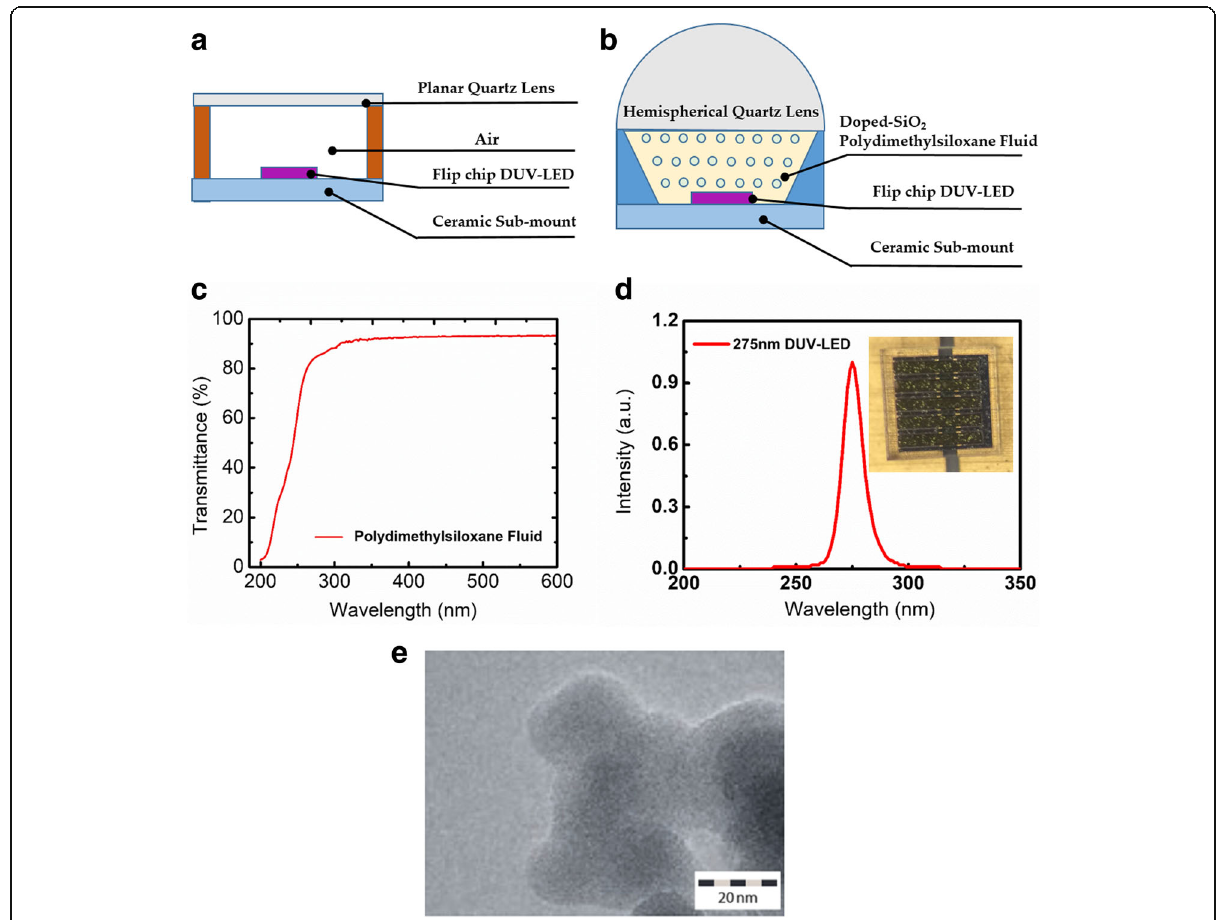
Fig. 2 DUV-LED encapsulation structure: a Schematic of conventional flip chip DUV-LED, b encapsulation structure and SiO 2 nanoparticle (NP) – doped polydimethylsiloxane (PDMS) fluid DUV-LED encapsulation structure, c transmittance of the PDMS fluid from 200 – 600nm, d photograph of the DUV-LED and emission spectrum captured at a forward current of 200mA for the proposed DUV-LED, and e high-resolution transmission electron microscopy image of SiO 2 NPs 26